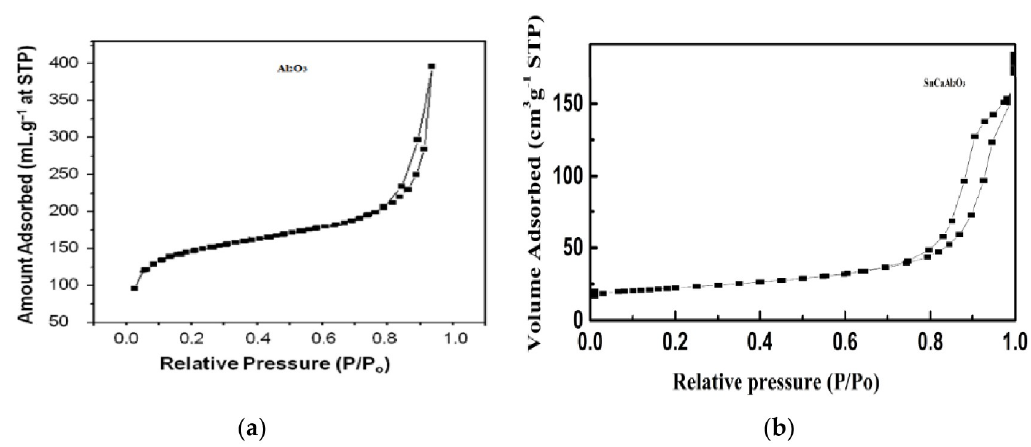
Fig 6. B.E.T. adsorption-desorption isotherm curve for (a) Al 2 O 3 and (b) SnCaAl 2 O 3 .